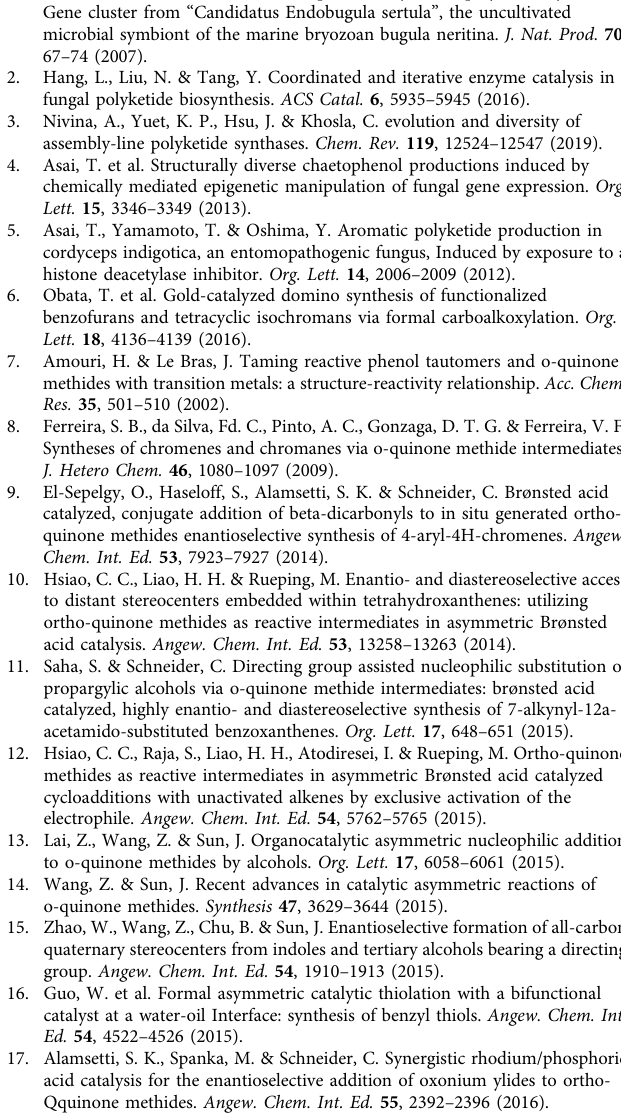
Experimental procedure for synthesis of 7 . Under Ar atmosphere, to a 10-mL test-tube were sequentially added 4d (0.2 mmol, 68.4 mg) (89% ee ), CH 2 Cl 2 (2.0 mL), Et 3 SiH (0.2 mmol, 23.2 mg) and TiCl 4 (0.1 mL) in 0°C. Upon completion (2 h) the residual was puri fi ed by silica gel fl ash chromatography (petroleum ether: